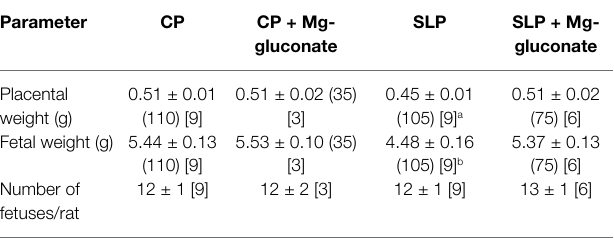
Values in parentheses indicate the total number of fetuses studied. Values in brackets indicate the total number of mothers studied in each case. Values expressed as the mean ± S.E. Comparisons between treatment conditions were assessed by one-way ANOVA with the post-hoc analysis with the Student–Newman–Keuls test. For both placental and fetal weights, value of p for the ANOVA test was <0.001. a p < 0.001 vs. CP; p < 0.01 vs. SLP + Mg-gluconate. b p < 0.001 vs. CP, vs. SLP +